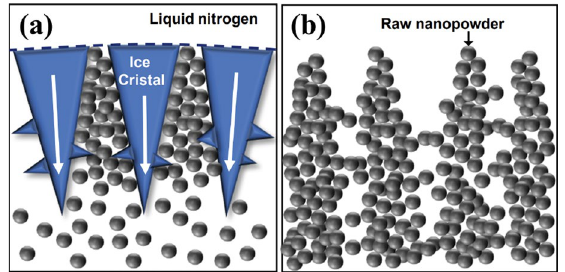
Figure 10. ( a ) Schematic diagrams of ( a ) ice crystal growth during the freezing process and ( b ) ice sublimation during the freeze-drying process. The white arrows in ( a ) indicate the direction of ice crystal